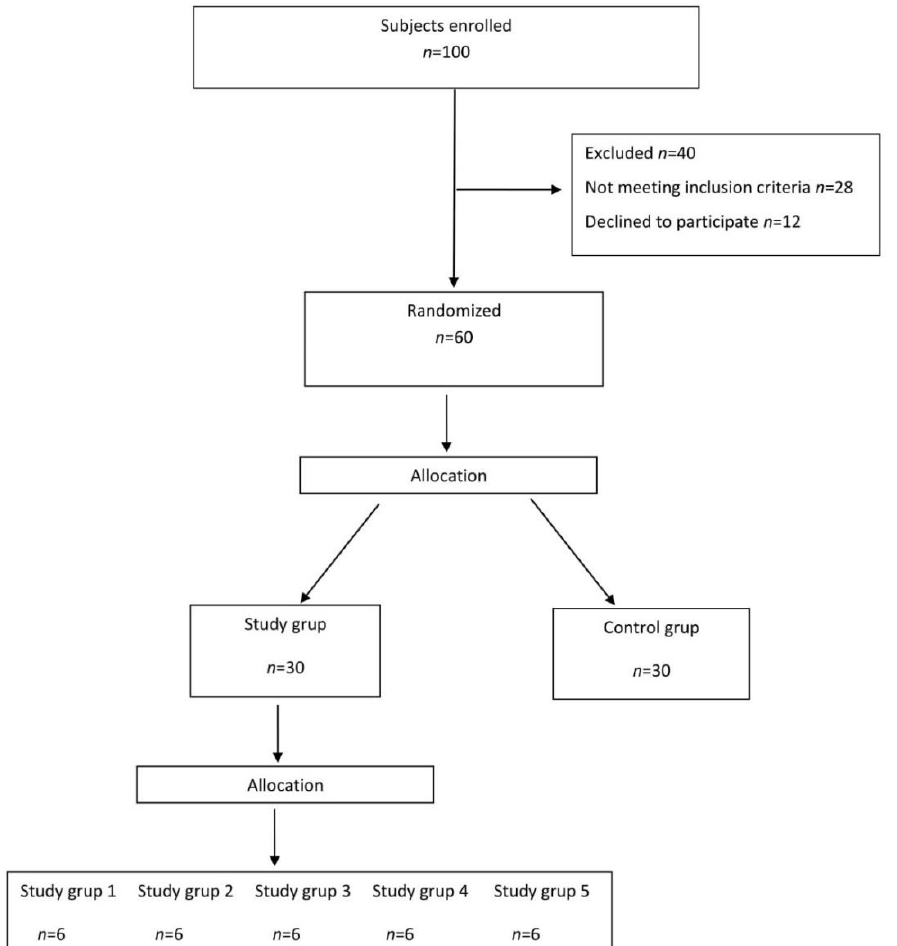
Figure 1. Flow of subjects through the study.